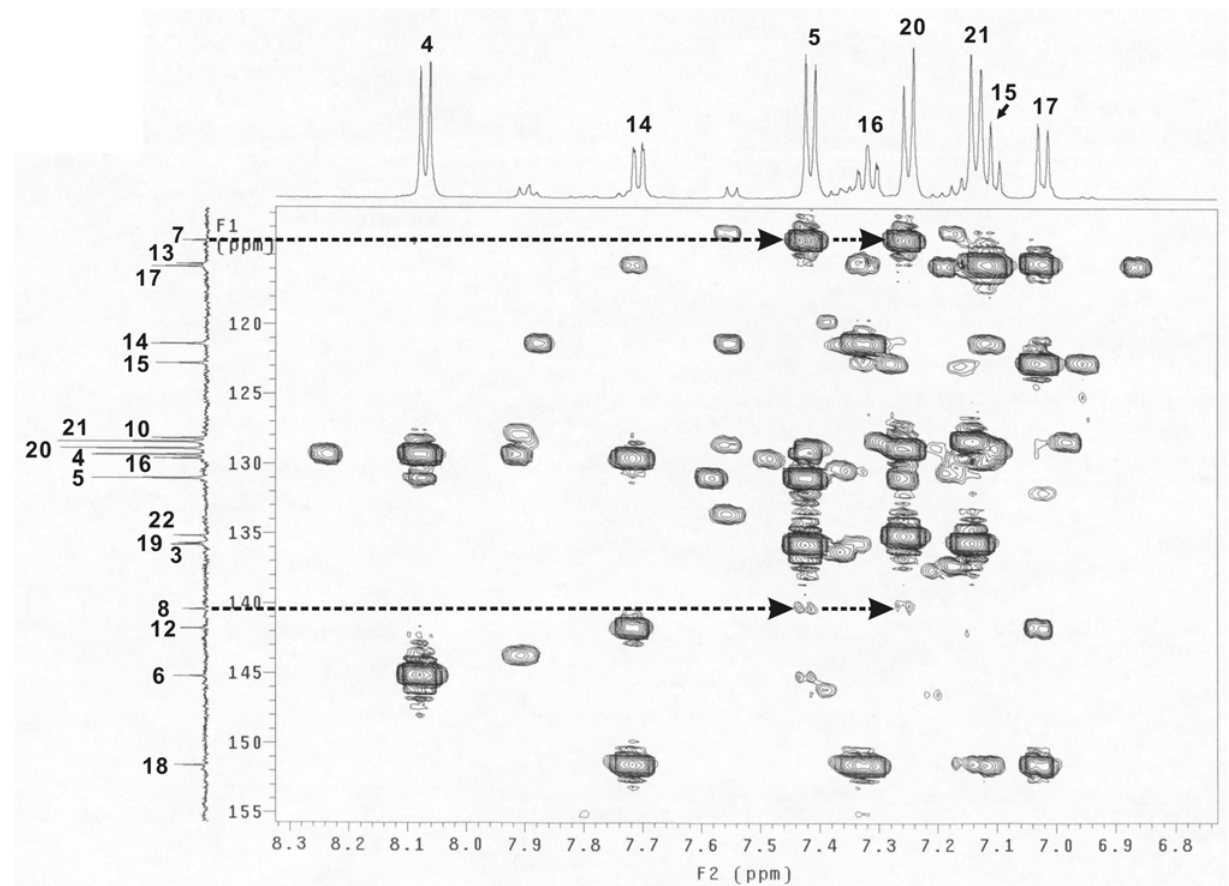
Figure 4. Part of the HMBC spectrum (dashed lines with arrows indicating the cross peaks of C7-H5, C7-H20, C8-H5 and